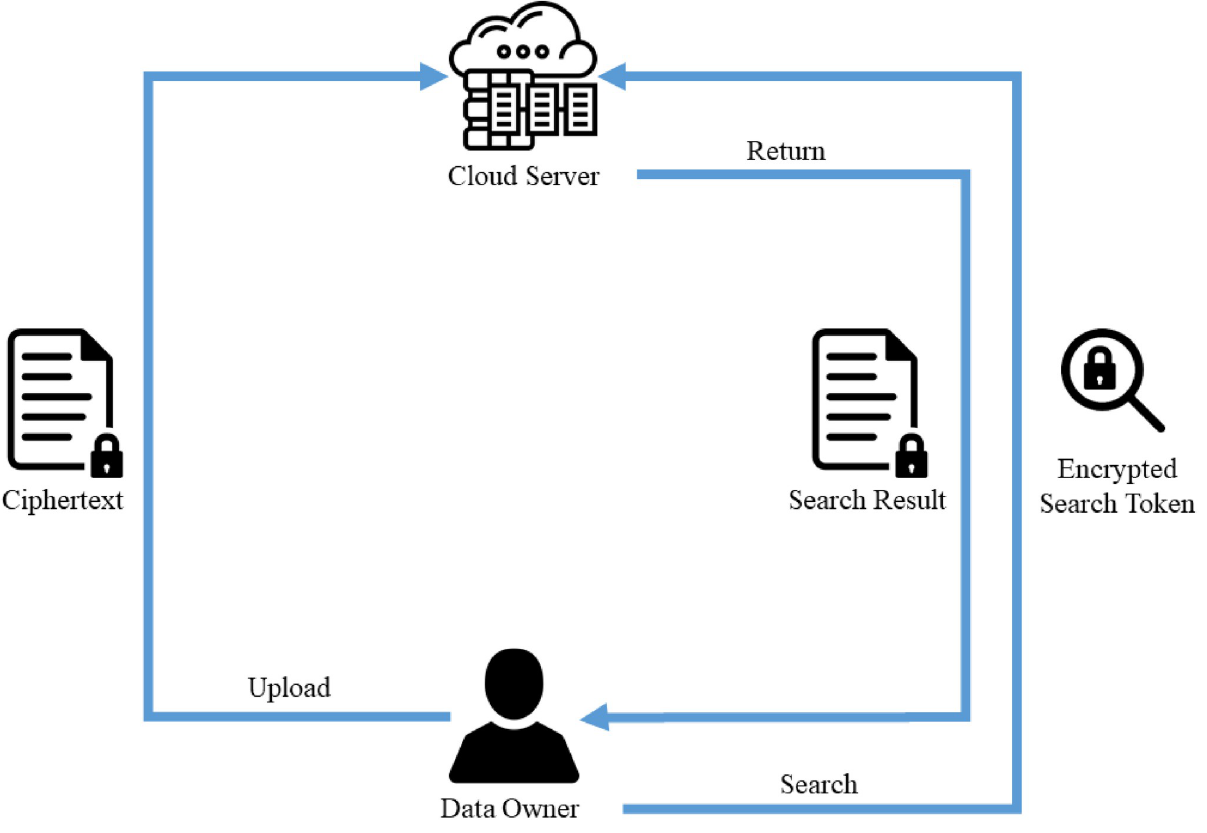
Fig 1. Illustration of a simple searchable